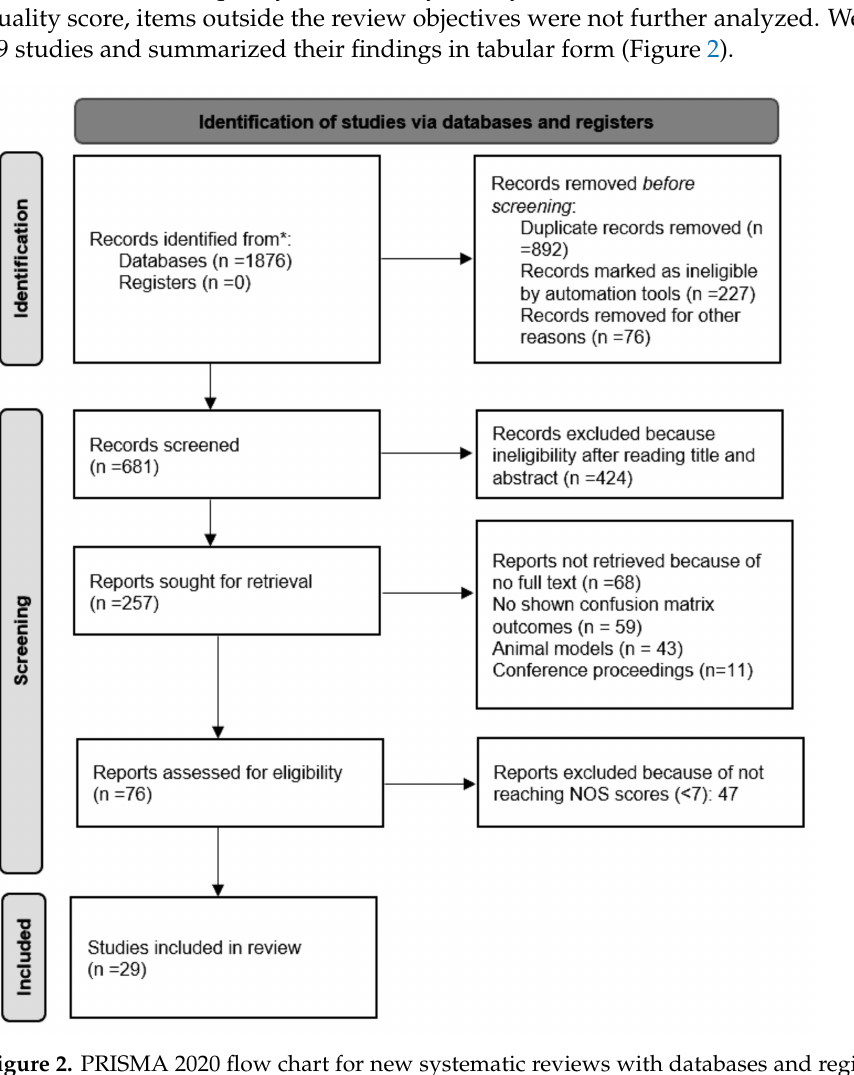
Figure 2. PRISMA 2020 flow chart for new systematic reviews with databases and registry search (*records extracted from only mentioned